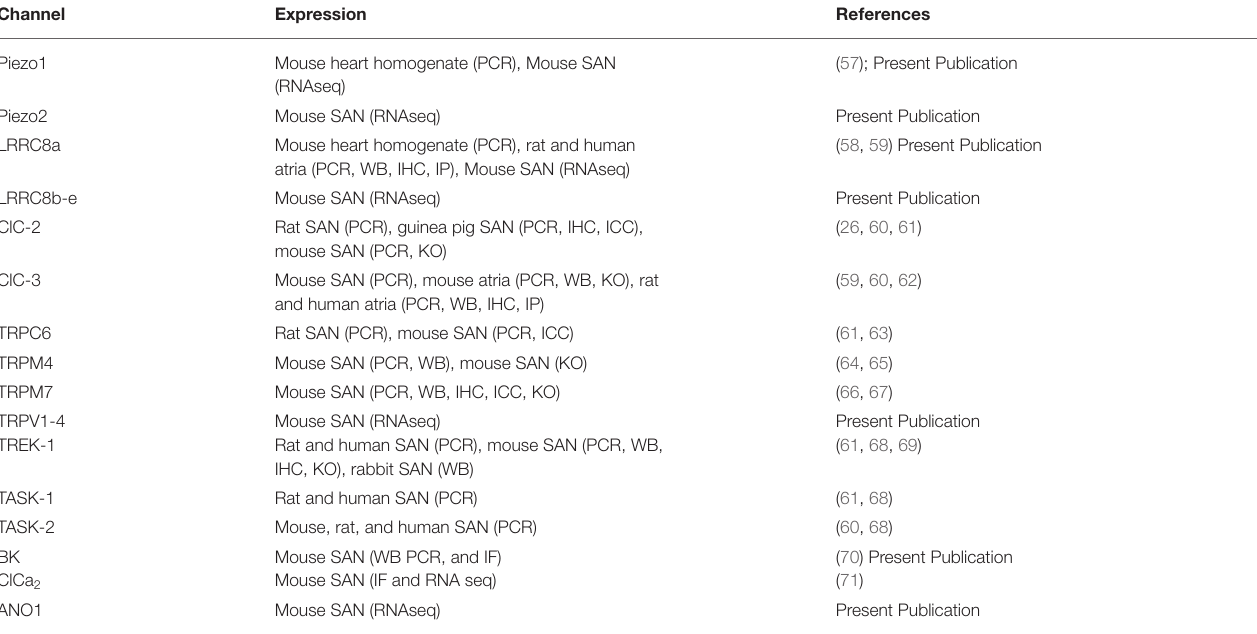
TABLE 1 | Compiled mechanosensitive ion channels discussed in the review, their known expression and detection method, and respective references. Channel Expression